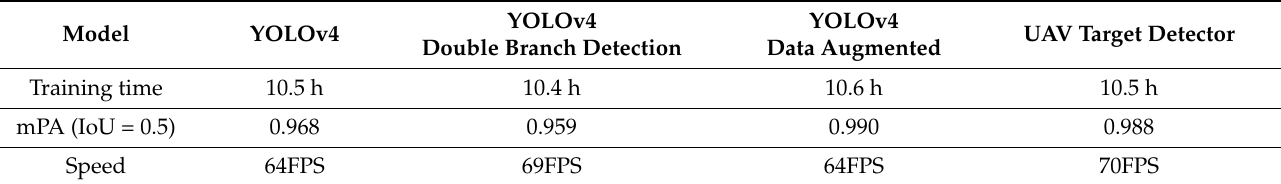
Table 3. Model checking performance